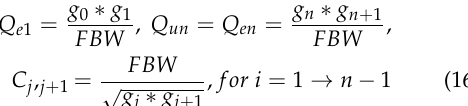
results of the ”3 r d − order ” dipole antenna filter.